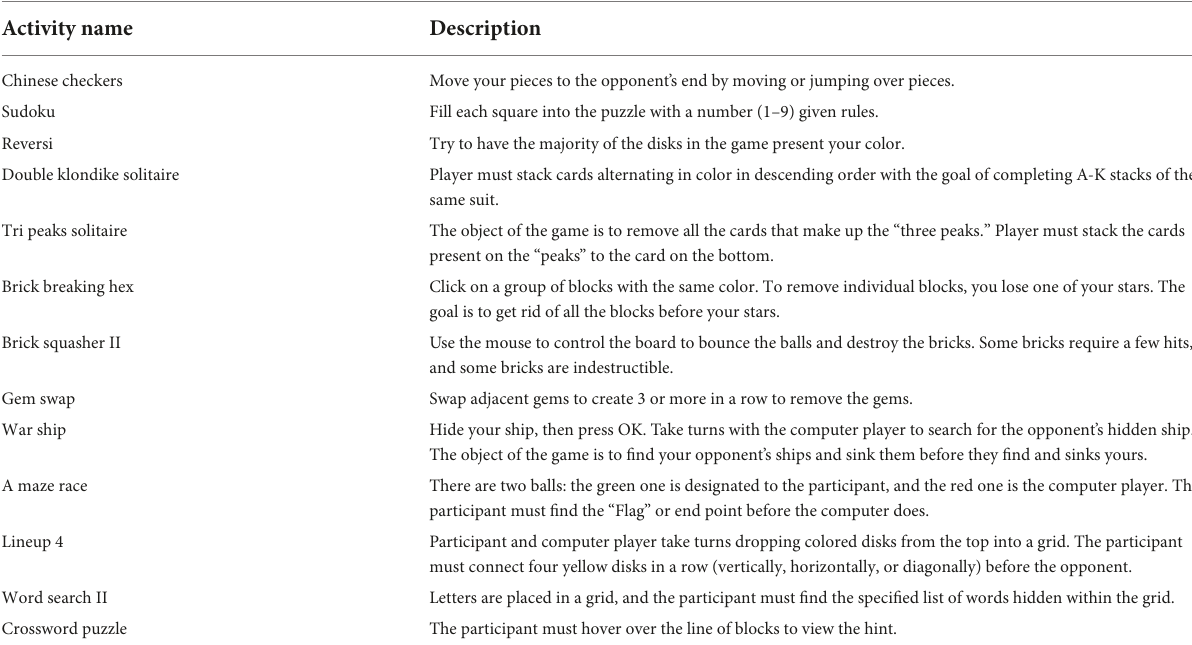
TABLE 2 List of activities in the control (CON)